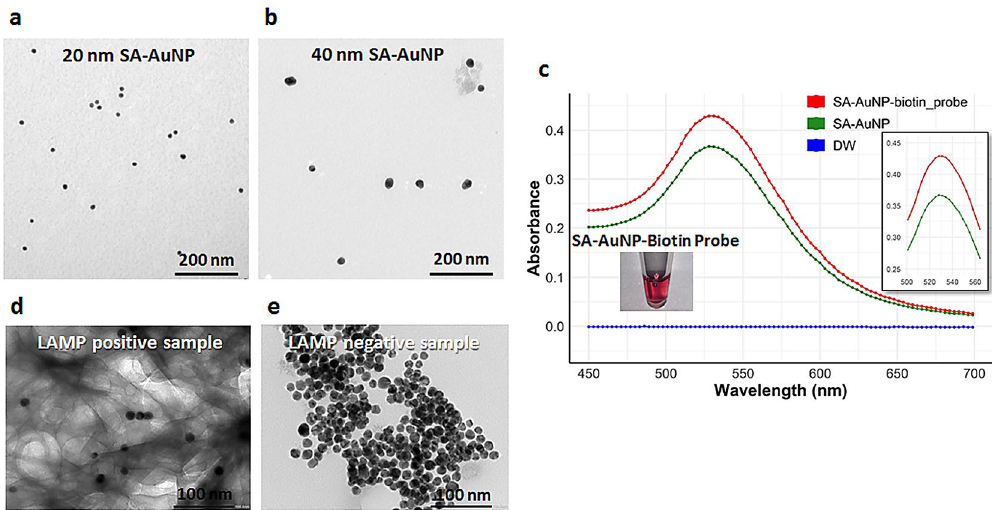
Figure 4. Characterization of SA-AuNPs and probe-SA-AuNPs, ( a ) transmission electron microscopy (TEM) imaging of SA-AuNPs at 20 nm size, ( b ) TEM imaging of SA-AuNPs at 40 nm size, ( c ) absorbance spectra of colloidal SA-AuNPs and probe-SA-AuNPs (SA-AuNP-biotin probe), ( d ) TEM of positive samples with probe- SA-AuNPs, ( e ) TEM of negative samples with probe-SA-AuNPs.